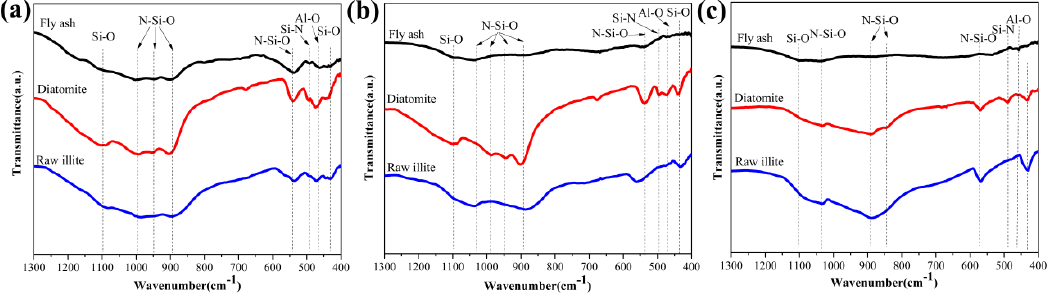
Figure 3. FT-IR spectra of the products obtained from different starting materials ( a ) 1350 °C ( b ) 1400 °C ( c ) 1450 °C.